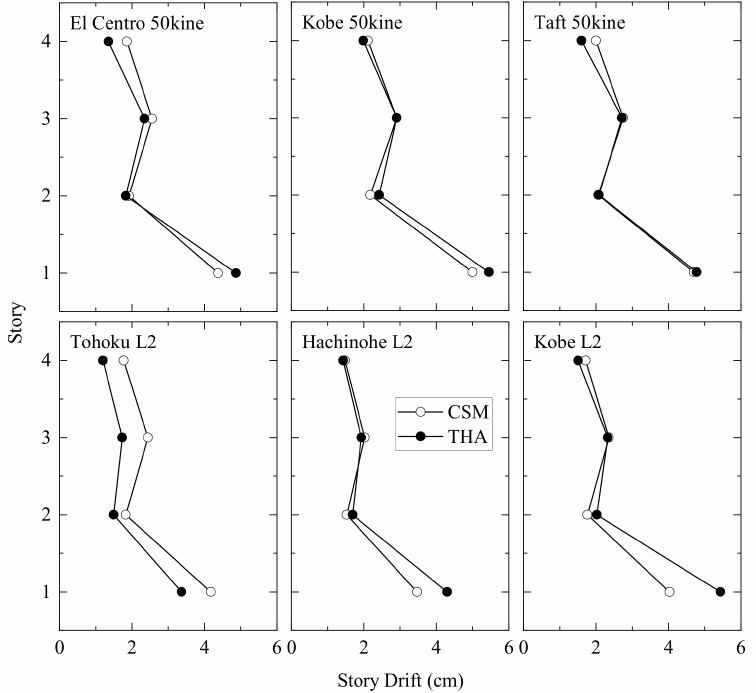
Figure 11. Comparison of story drifts between proposed CSM and time history analysis (THA) for 4-story